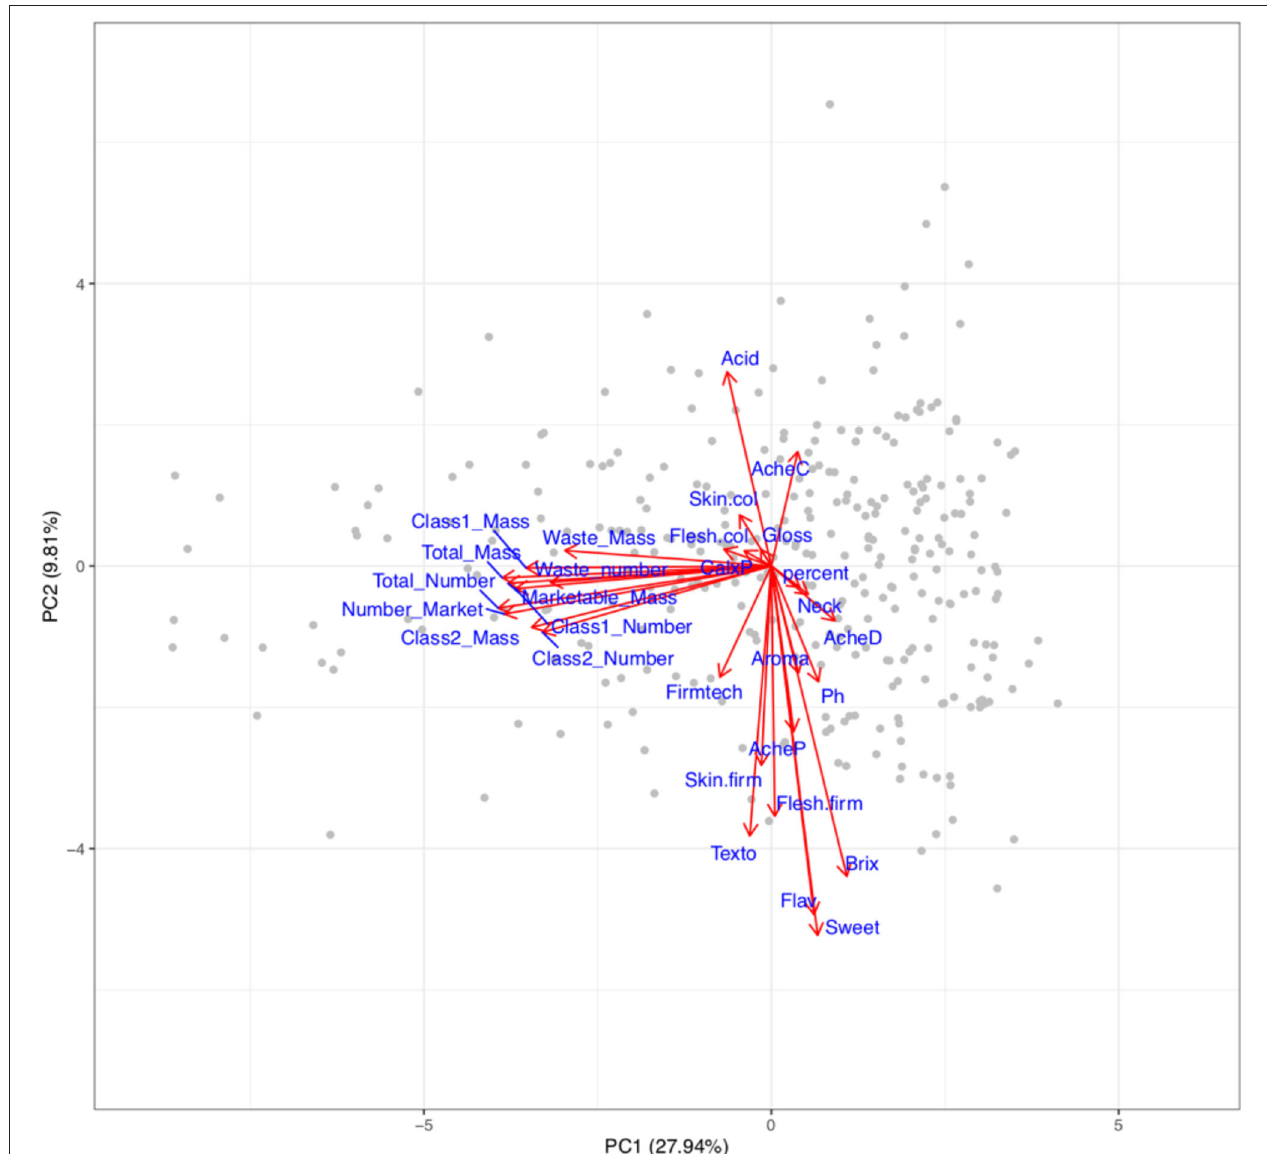
FIGURE 3 | Biplot representing variation in fruit quality and yield traits within the multi-parental strawberry population. Numbers in brackets represent the proportion of variation explained by principal components (PC). Red arrows indicate the relative influence a trait has on the PC each associated with the trait denoted by a blue label. Grey points represent genotypes. CalxP, calyx position; Skin.col, skin colour; Flesh.col, Flesh colour. Acid, acidity perception; AcheC, Achene colour; Neck, Neck position; Shape, height:width; Texto, texture rating overall, Fimtech, automated firmness; Flesh. Firm, flesh firmness manual; Skin.firm, skin firmness;